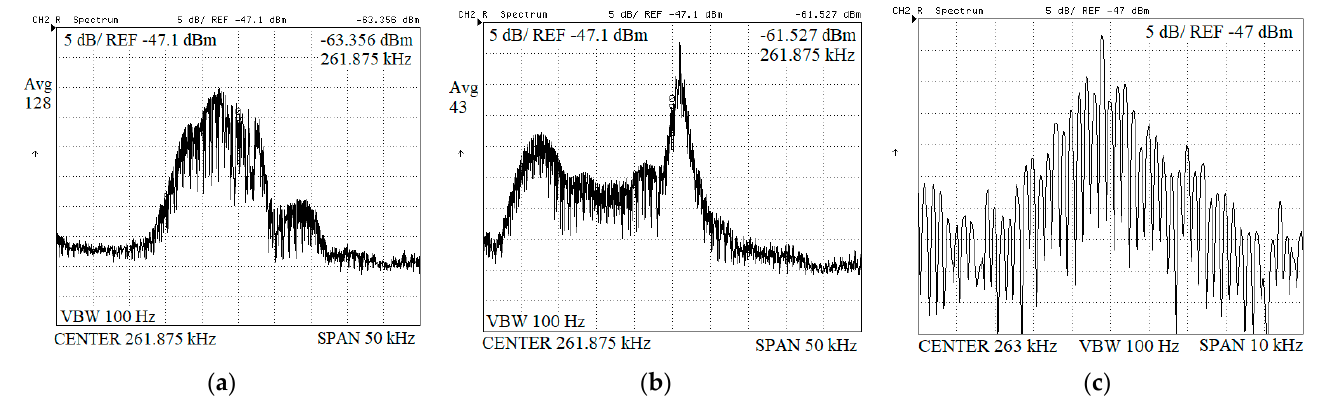
Figure 8. The spectra of PD3 outputs (5 dB/REF − 47 dBm, center frequency 261 kHz) ( a ) without the waveform control (span 50 kHz) and ( b ) with the waveform control for linear tuning (span 50 kHz) and ( c ) expanded view of the spectral peak (span 10 kHz).